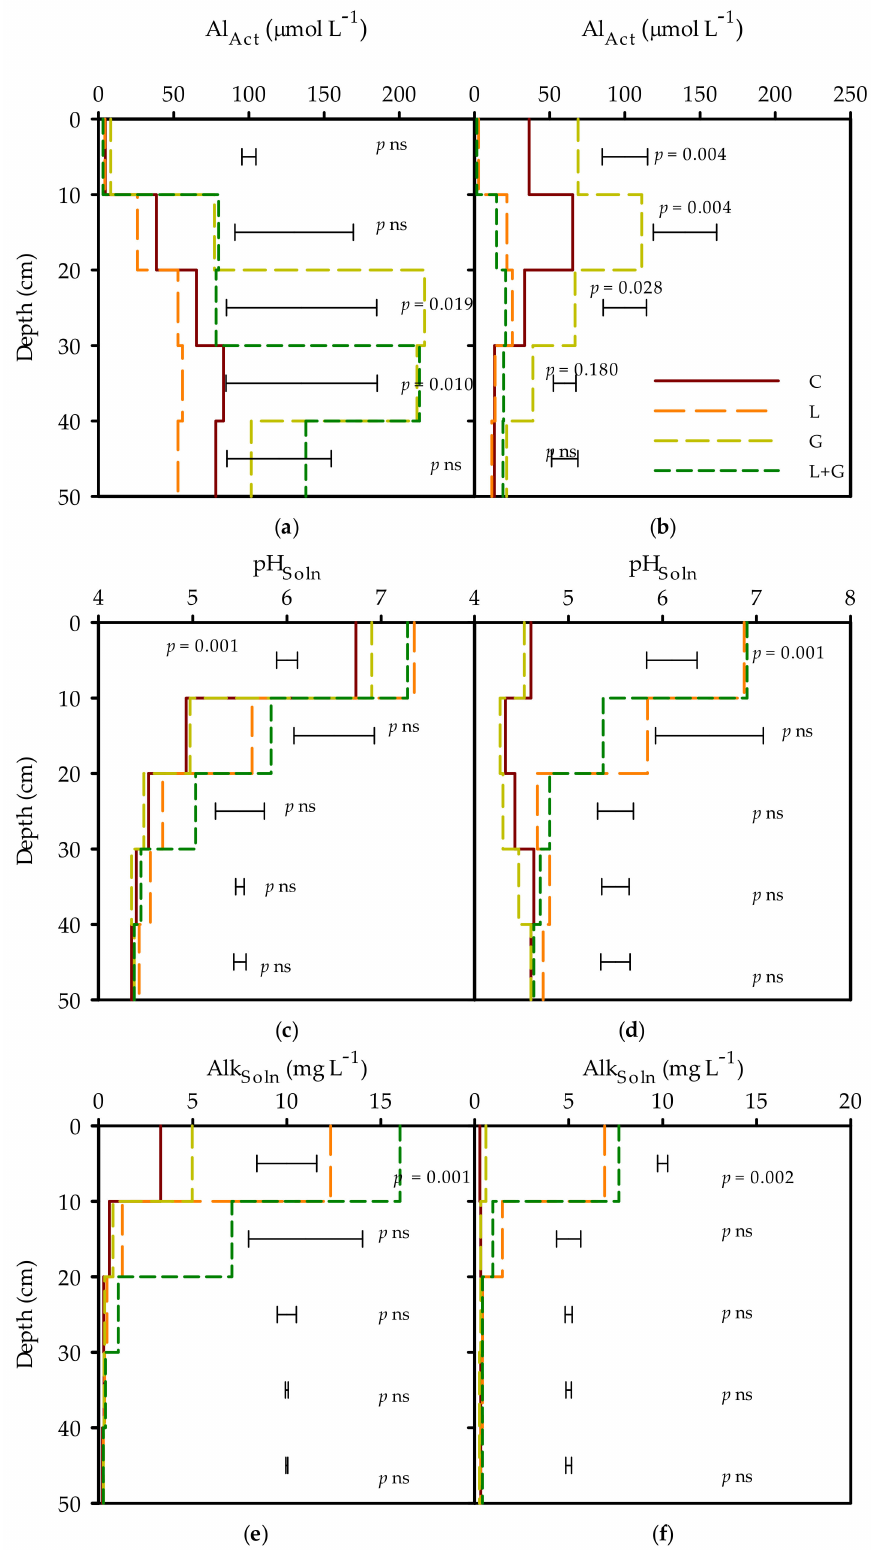
Figure 2. ( a , b ) The soil solution Al activity (Al Act ) ( µ mol L − 1 ), ( c , d ), pH (pH Soln ), and ( e , f ) alkalinity (Alk Soln ) (mg L − 1 ), ( a , c , e ) in the ST ( b , d , f ) and LT ( b , d , f ) for the C, L, G, and L + G treatments. The error bars represent the least significant difference values at p = 0.05, n = 3 for each depth with ns denoting p >